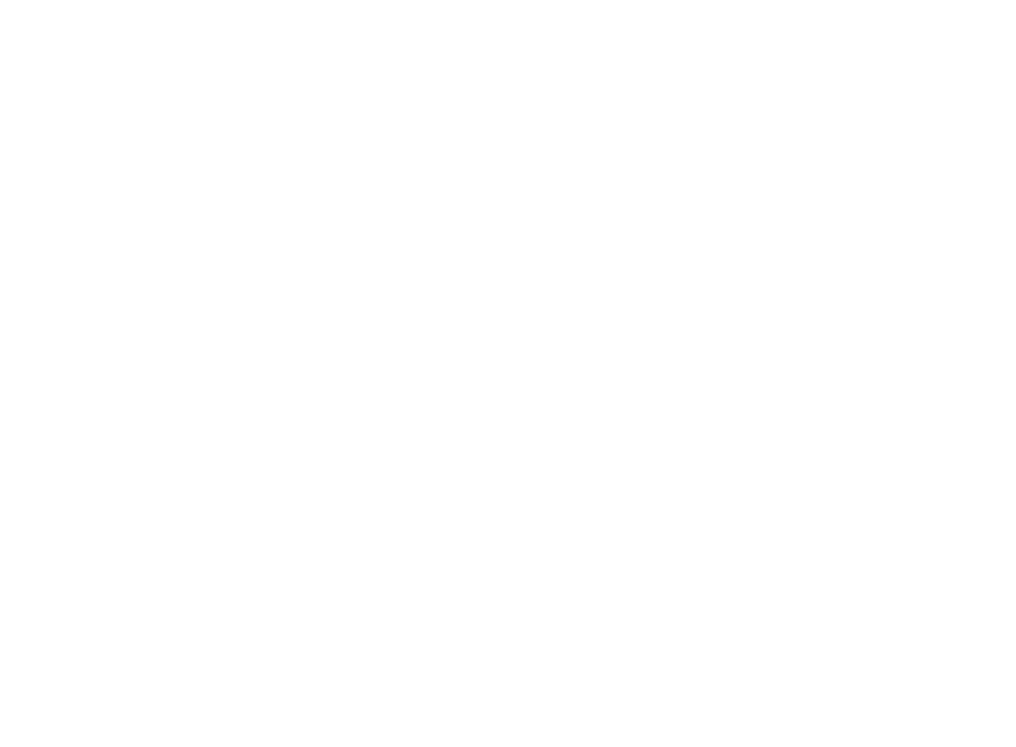
FIG. 1. Myeloperoxidase (A), adenosine deaminase (B), neutrophil (C) and mononuclear (D) values determined for the pleural lavage in the early (4h) and late (48h) phases of pleurisy induced by carrageenan in mice. C, Control values obtained for sterile-